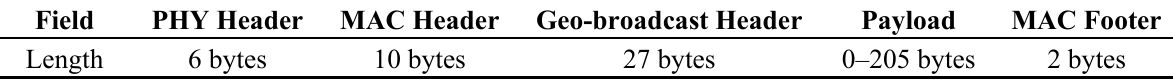
Table 1. Geo-broadcast data packet.